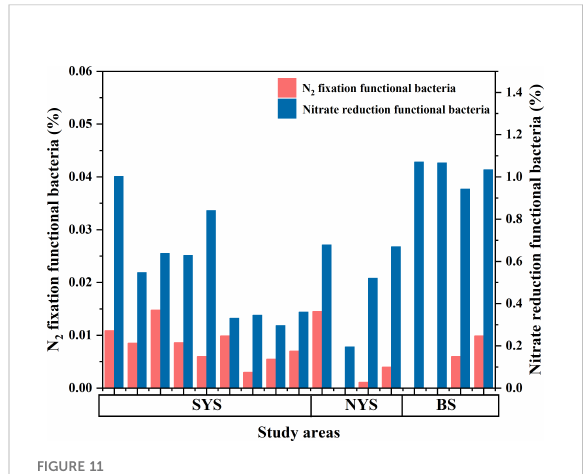
FIGURE 11 The relative abundances of bacteria with N 2 fi xation and nitrate reduction function. The function prediction was performed by the FAPROTAX software based on 16s rRNA